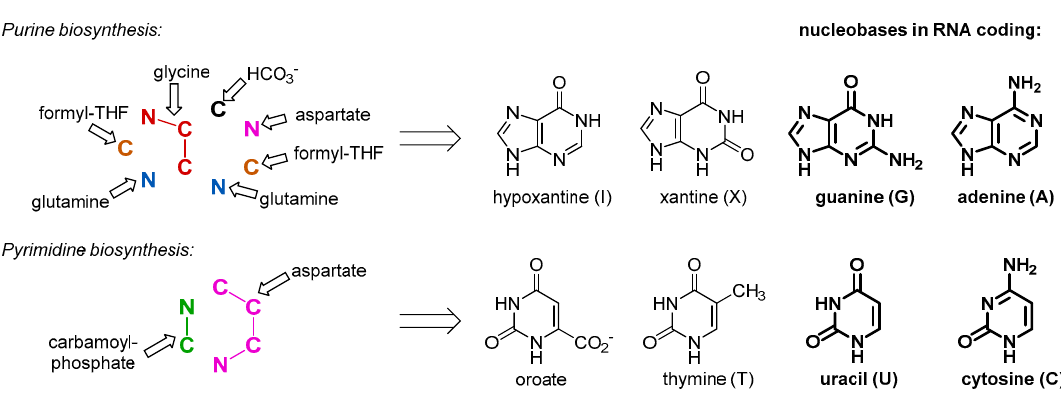
Figure 2. Relationship between the amino acids and nucleobases: all nucleobases are formed in metabolic reactions involving amino acid as sources of the building blocks.